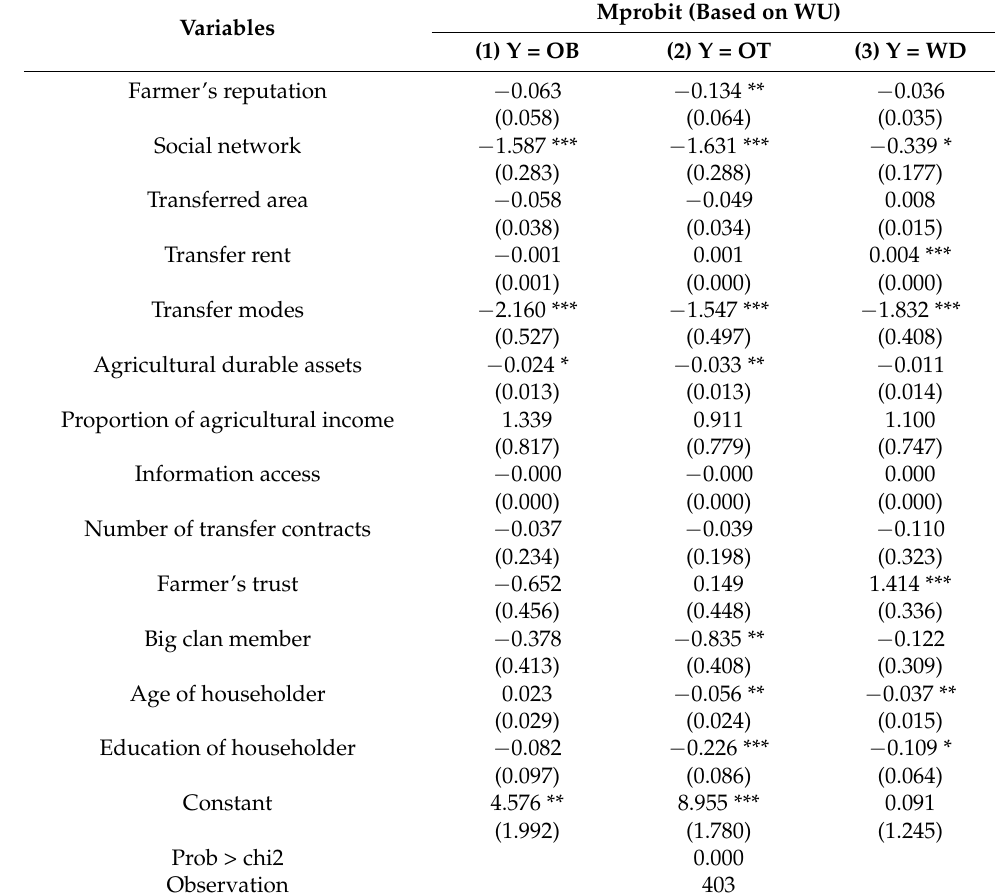
Table A3. The results of Mprobit model of contract form